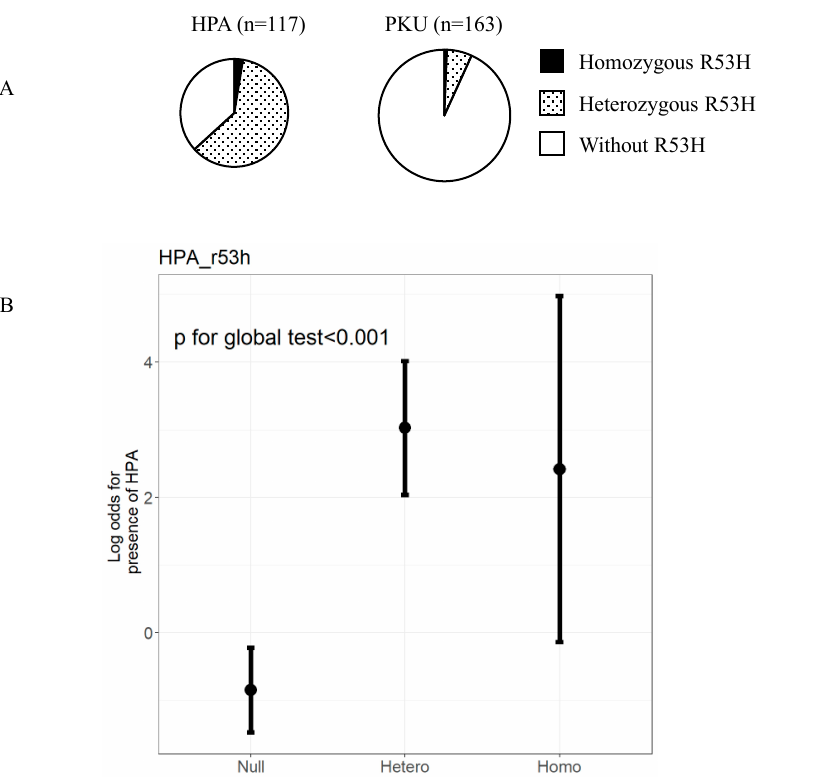
Figure 2. p.R53H variant is observed at a higher frequency in patients with HPA phenotype than in patients with PKU phenotype. ( A ) Number of patients with R53H variant in PAH (p.R53H) in each of the 280 patients with a known phenotype of either HPA or PKU. ( B ) Odds ratios for patients with no, heterozygous, and homozygous p.R53H variant to develop HPA phenotype. HPA, hyperphenylalaninemia; PKU, Phenylketonuria.